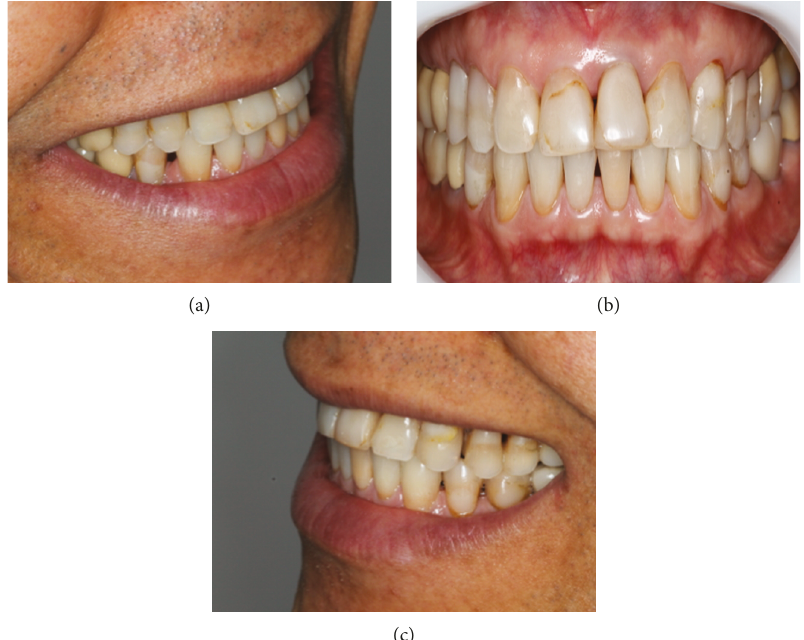
Figure 1: (a) Initial photo of patient ’ s right side. (b) Initial photo frontal view. (c) Initial photo of patient ’ s left